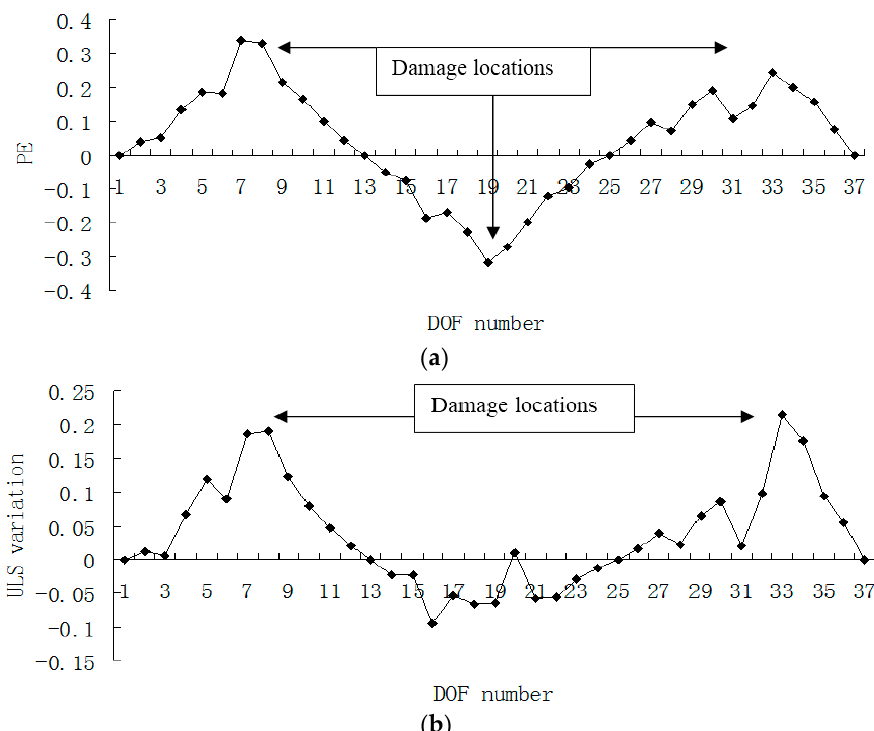
four modes without noise when elements 7, 19 and 33 are damaged (×10 − 3 ).